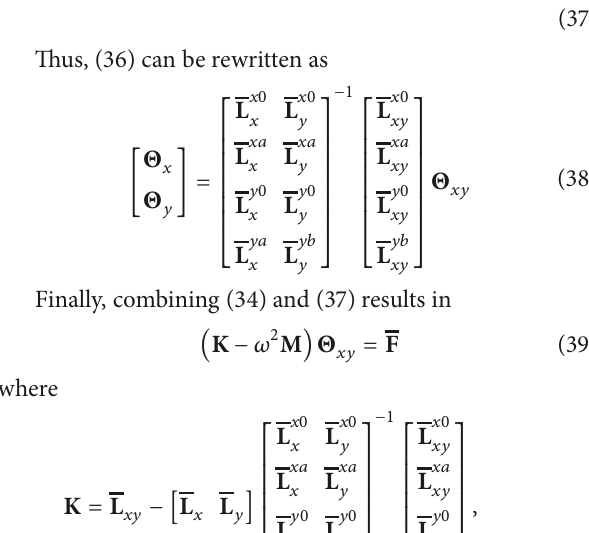
Table 4. Also, the deformations of the isotropic plates